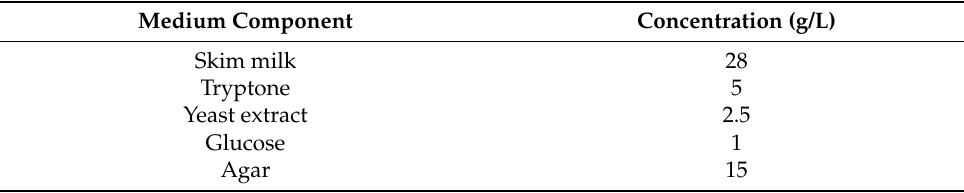
Table 1. Medium composition for the protease activity